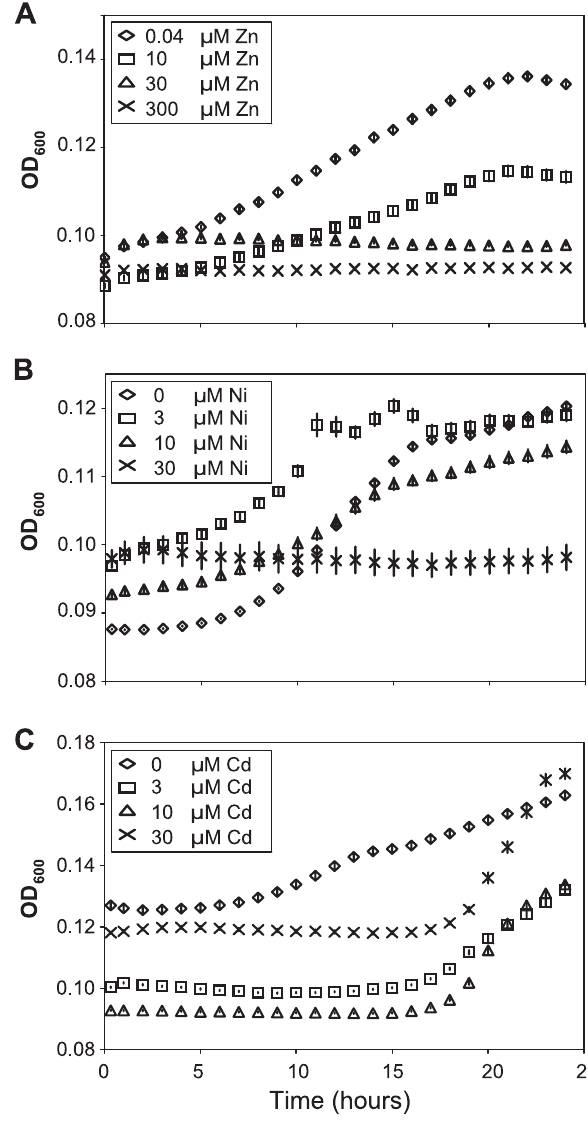
Figure 4. Apoplast extracts from Thlaspi caerulescens plants grown in high metal concentrations inhibit bacterial growth. Apoplast extracts obtained from T. caerulescens plants treated with the same zinc ( A ), nickel ( B ), or cadmium ( C ) concentrations used in the bacterial colonization assays shown in Figure 3 were used as a growth medium for P. syringae pv. maculicola M4. Six samples of 100 m l of apoplast were used for each treatment. Values are means 6 SE ( n =6). The experiment was performed three times with similar results, and the results shown are from one experiment representative of the three . Concentrations of all three metals were significant predictors of growth at 18 and 24 hours (ANOVAs: P , 0.0005 in all cases except P =0.015 for cadmium at 24 h). Bonferroni simultaneous comparisons ( a =1%) show that all zinc and nickel treatments resulted in significantly less growth than the control at 18 h and 24 h, as did all cadmium treatments up to 18 h.